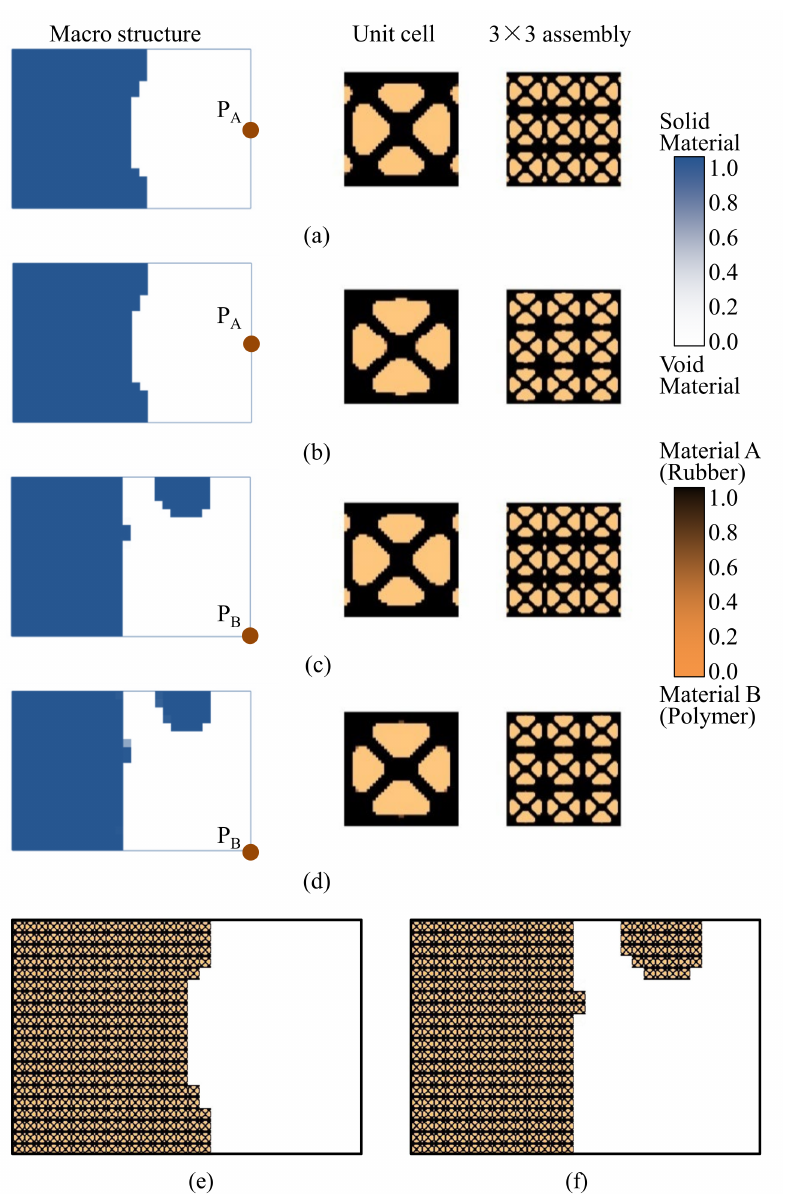
Figure 7. Optimal composite plates under different initial microstructures and excitation positions. The excitation frequency range is 0–60 Hz. ( a ) Initial guess 1, excitation position P A , the dynamic compliance of the optimal structure is 5.540 N · mm. ( b ) Initial guess 2, excitation position P A , the dynamic compliance of the optimal structure is 5.580 N · mm. ( c ) Initial guess 1, excitation position P B , the dynamic compliance of the optimal structure is 6.720 N · mm. ( d ) Initial guess 2, excitation position P B , the dynamic compliance of the optimal structure is 6.784 N · mm. ( e , f ) are the overall composite plates for the results shown in ( a , c